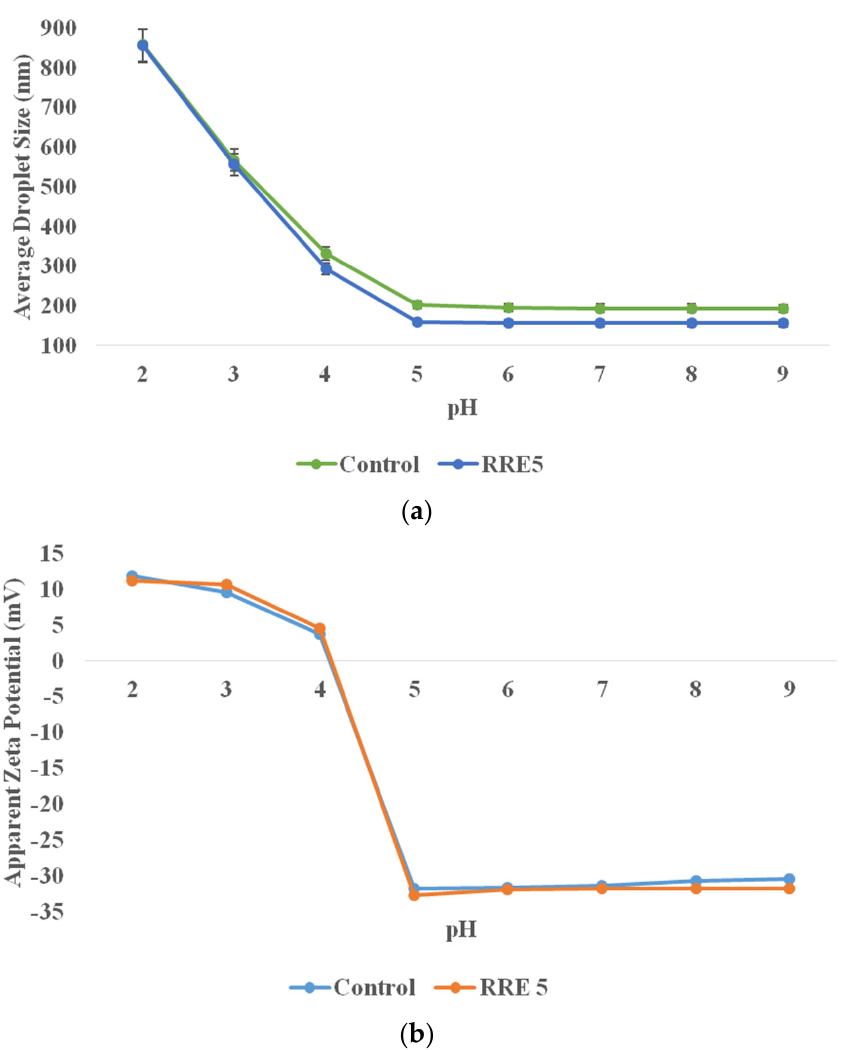
Figure 5. ( a ) Effect of pH on average droplet size, and ( b ) effect of pH on apparent zeta potential of RRE5 nanoemulsion. Data are presented as means ± SD ( n = 3).